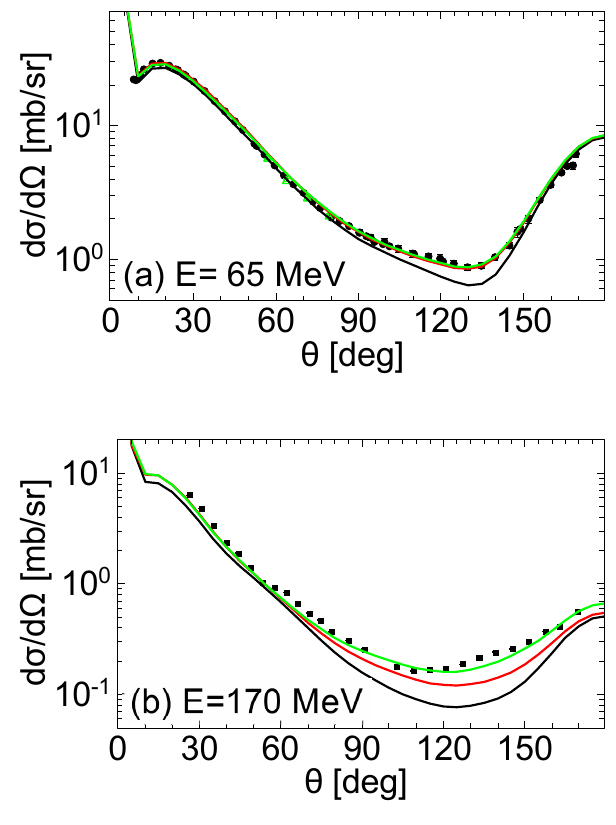
= 65 MeV and (b) p , and 660